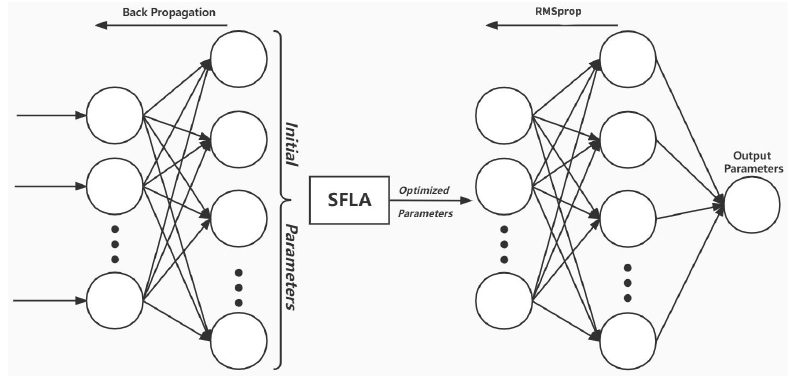
Figure 4. Structure diagram of the proposed